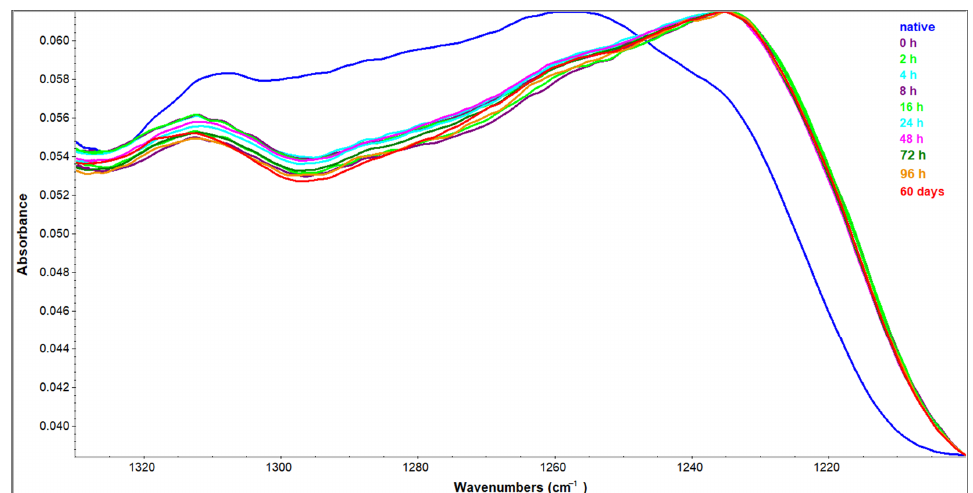
Figure 7. Amide II region of HEWL native sample in H 2 O solution and HEWL samples incubated in 90% C 2 H 5 OH for the time period indicated.